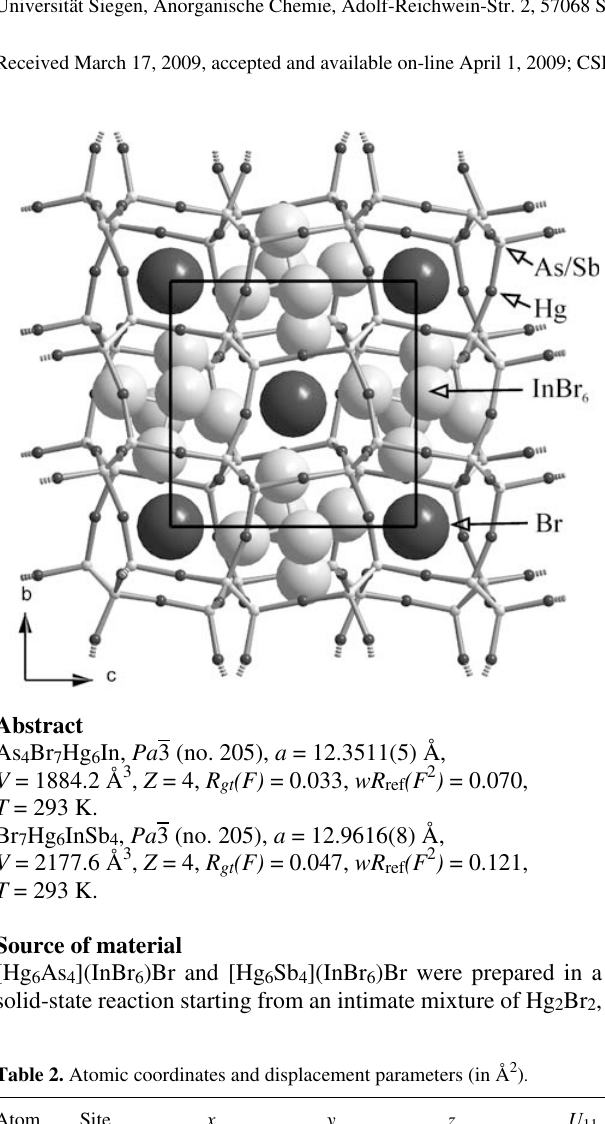
HgBr 2 , As (Sb) and In in the molar ratio 5 : 2 : 8 : 2 which was filled into a dry quartz glass ampoule ( l = 20 cm, d = 1.8 cm). The sealedampouleswereheatedupto553K,keptatthistemperature for 16 days and finally cooled down to room temperature. Both compounds show up as transparent, dark red crystals which are handeled under Argon. Both compounds show a moderate air sensitivity.